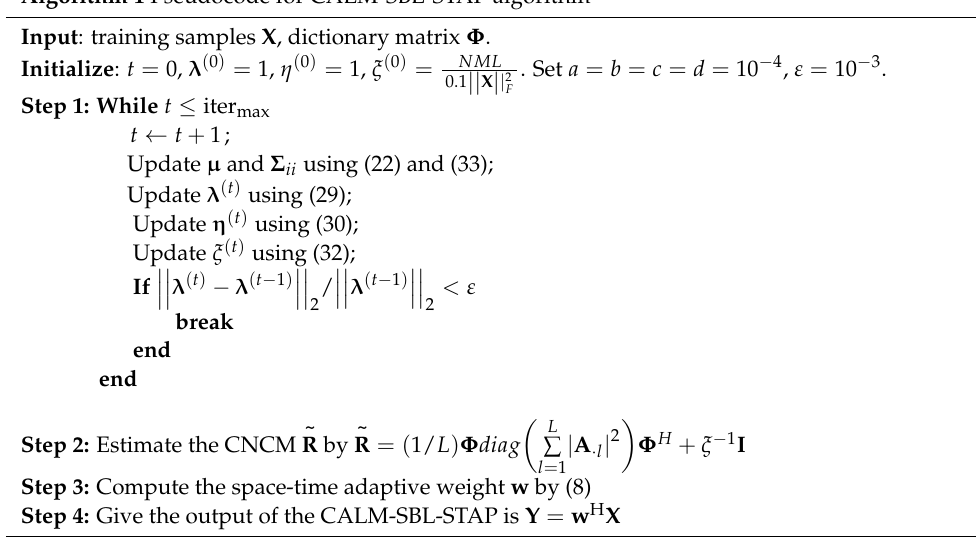
Algorithm 1 Pseudocode for CALM-SBL-STAP